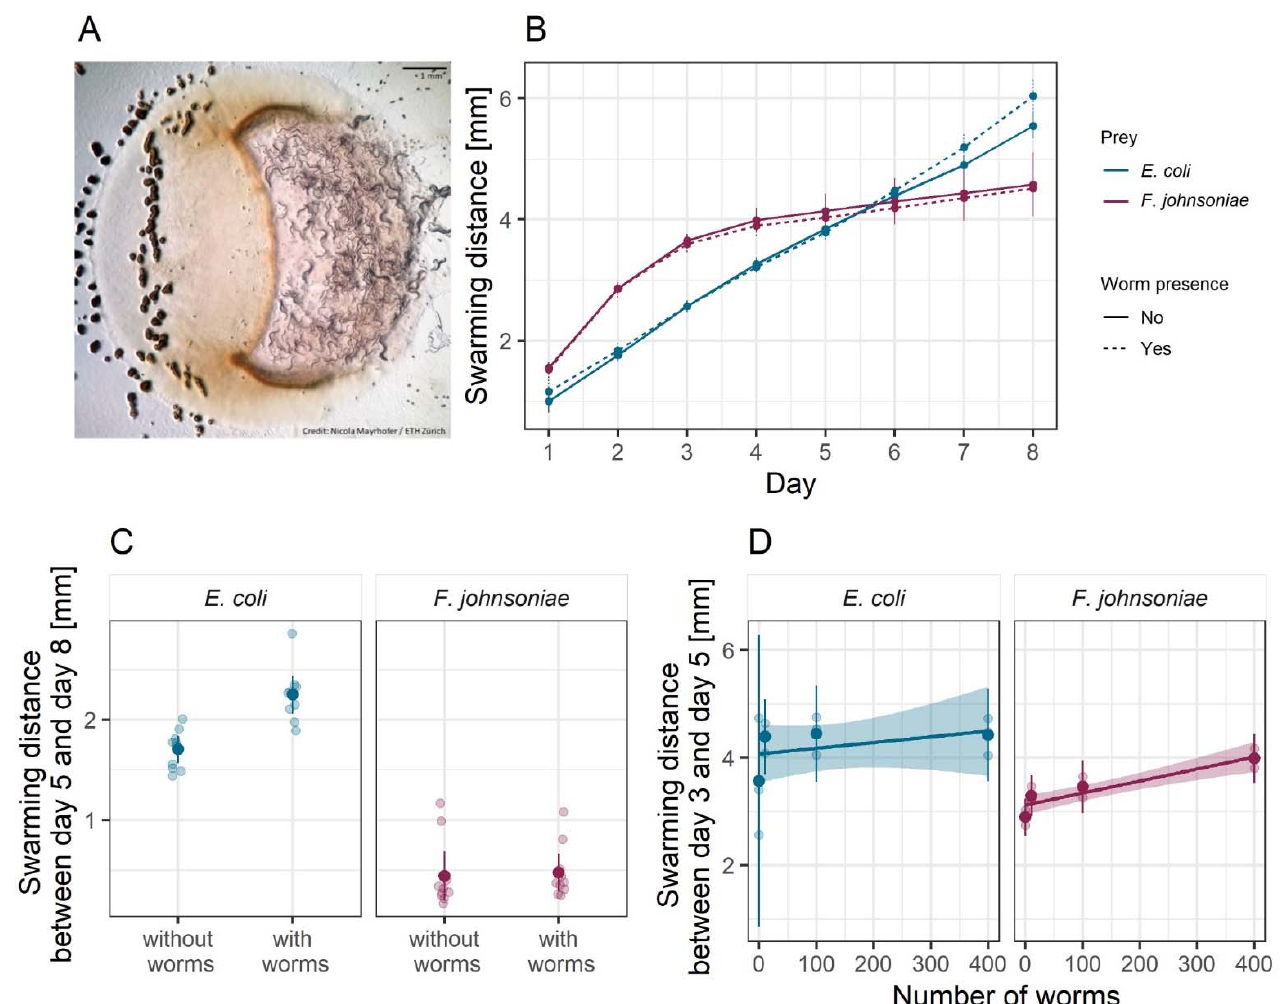
Figure 5. C. elegans presence increases M. xanthus predatory swarming rate . ( A ) Picture of C. elegans (right) and M. xanthus strain S (orange lawn and black fruiting bodies on the left) preying upon an E. coli patch (raised circle). We estimated the predatory performance of M. xanthus as the swarming distance along the horizontal midline of the prey patches of E. coli (blue) and F. johnsoniae (red). We show the swarming distance over time ( B ) in the presence (dotted lines) and absence (solid lines) of C. elegans’ populations initiated with 10 worms (which started reproducing at day 5), and the associated total swarming distances between days 5 and 8 ( C ) from the same experiment. Panel ( D ) depicts the total swarming distances between days 3 and 5 in the presence of different numbers of C. elegans (the worms did not reach maturity until day 5 and so did not reproduce during this experiment). Each large dot is the mean of ten ( B , C ) or three ( D ) biological replicates (shown as transparent dots). Error bars and shaded areas represent 95% confidence intervals of the means and the regression lines, respectively.